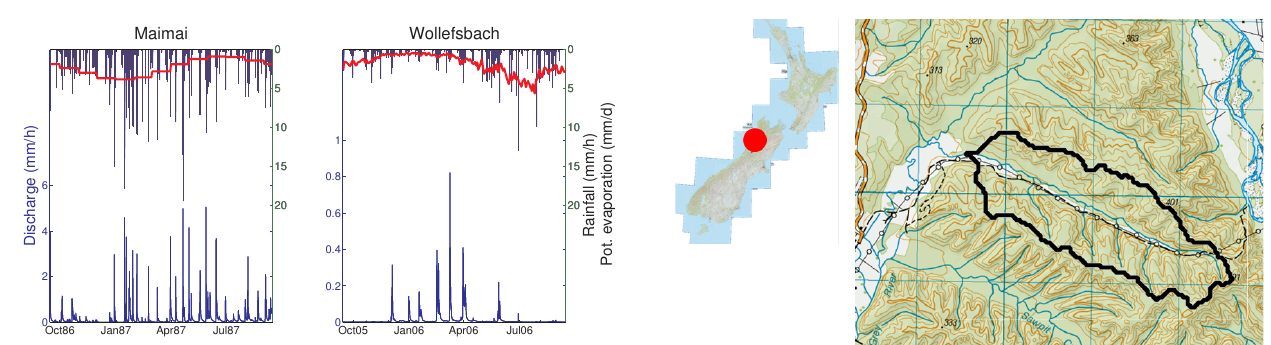
Fig. 3: Illustration of possible configurations for the PCA diagram: each vector represents an evaluation criterion (analysis is done per model structure). The axes are formed by the first two principal components (PC). (a) represents a fully consistent model structure, (e) a fully inconsistent model structure.